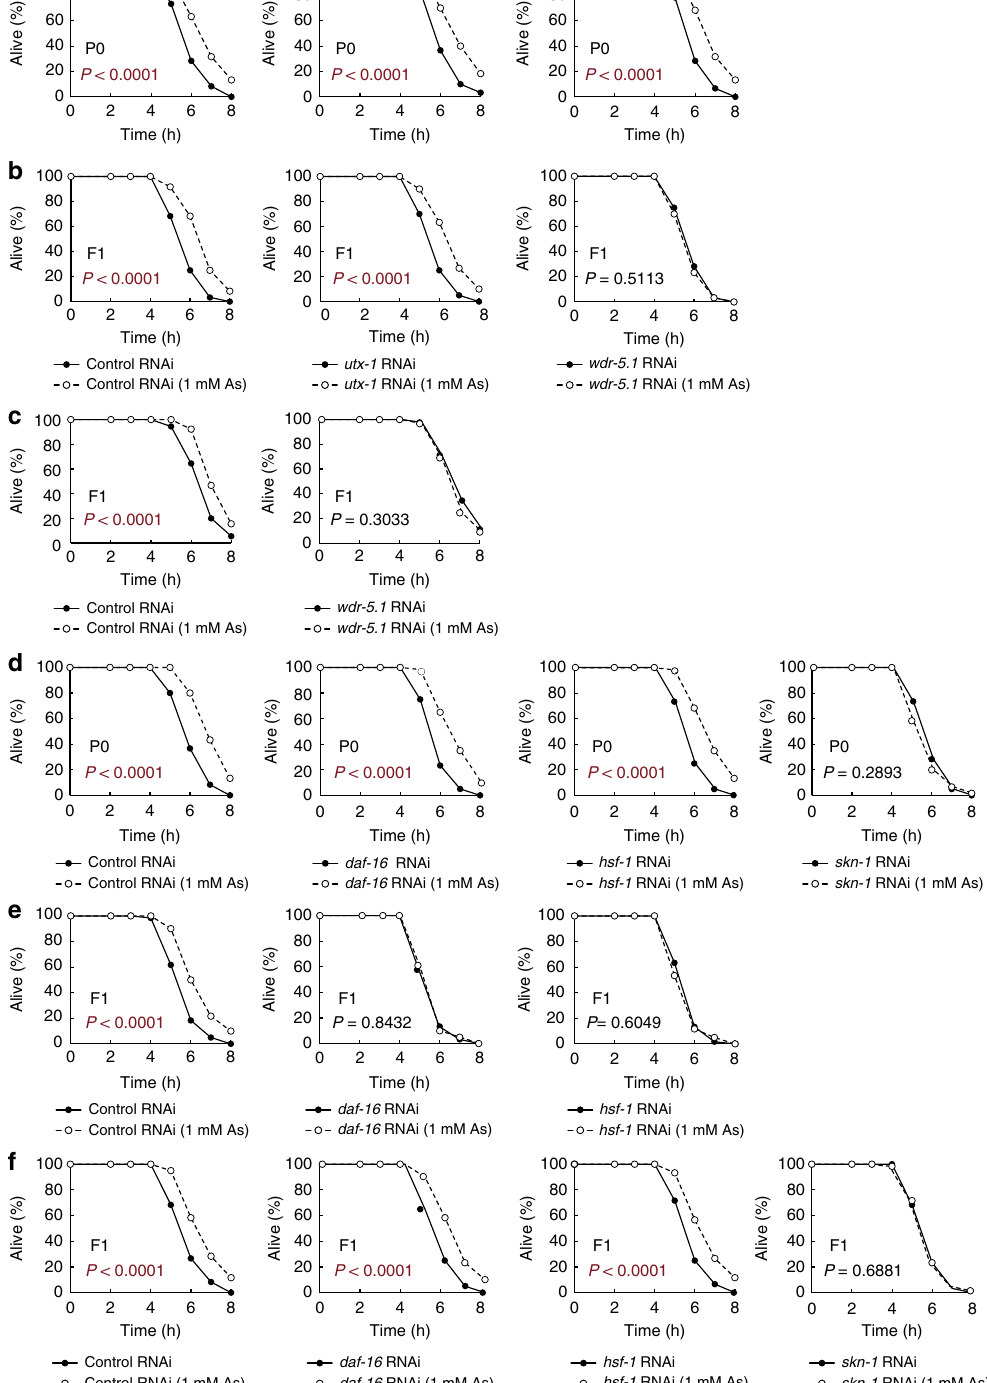
daf-16 RNAi daf-16 RNAi (1 mM As)